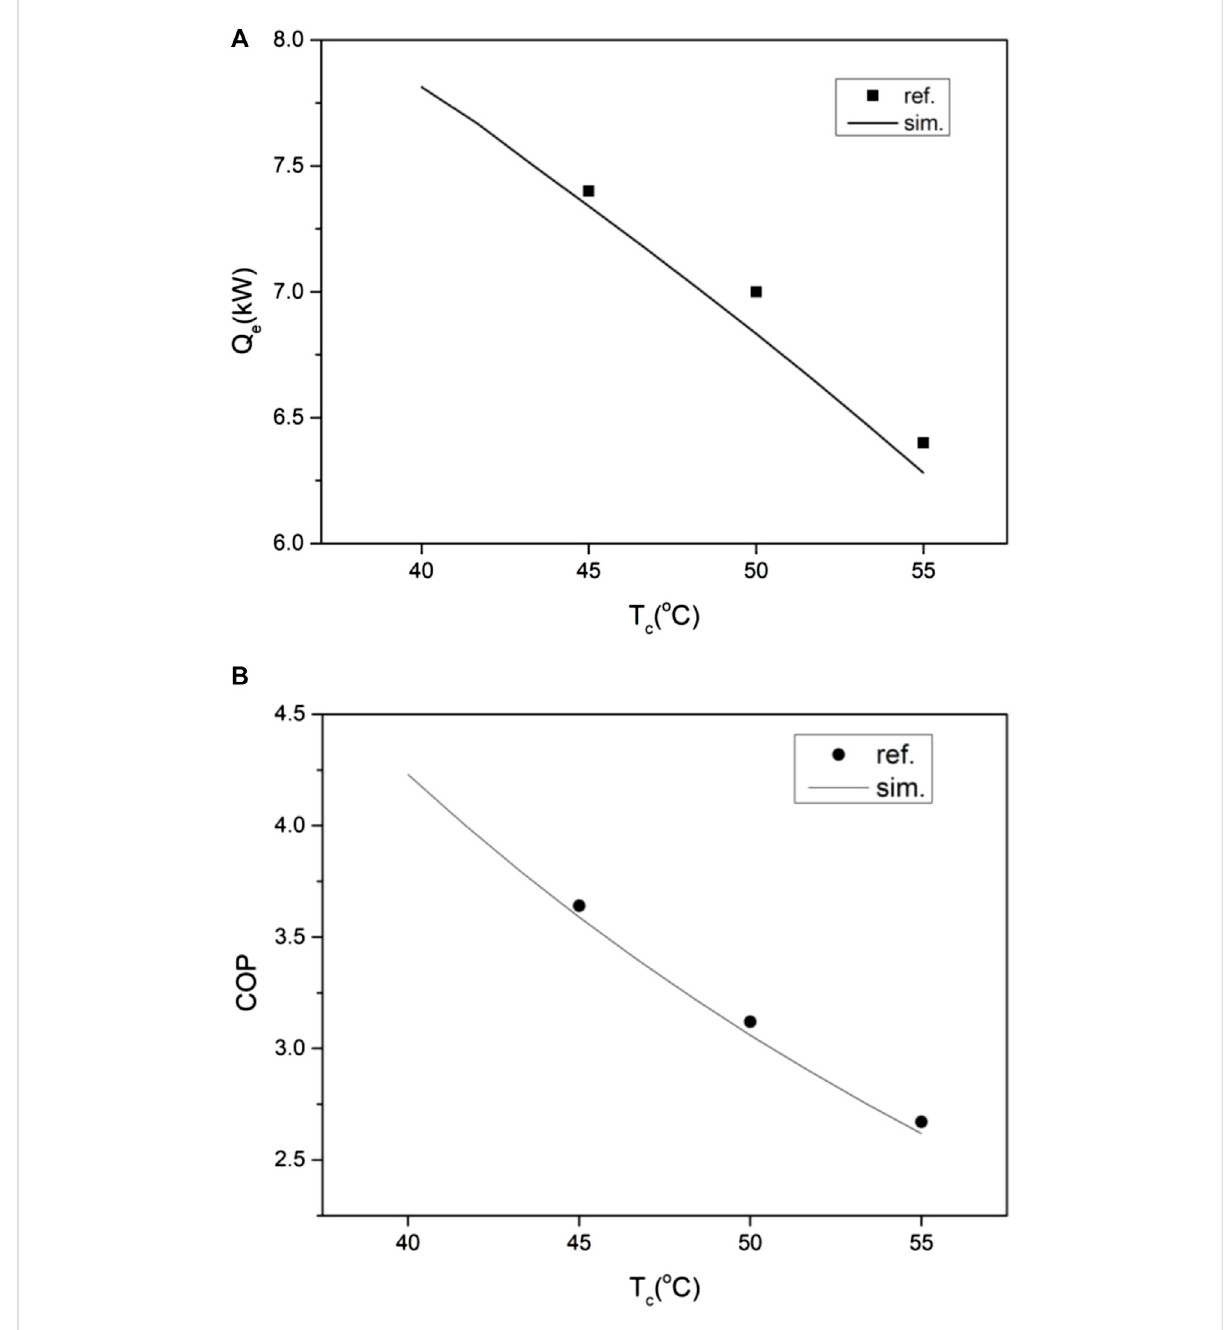
FIGURE 2 Validation of the numerical model equations for the heat pump: (A) cooling power (kW) and (B) COP.